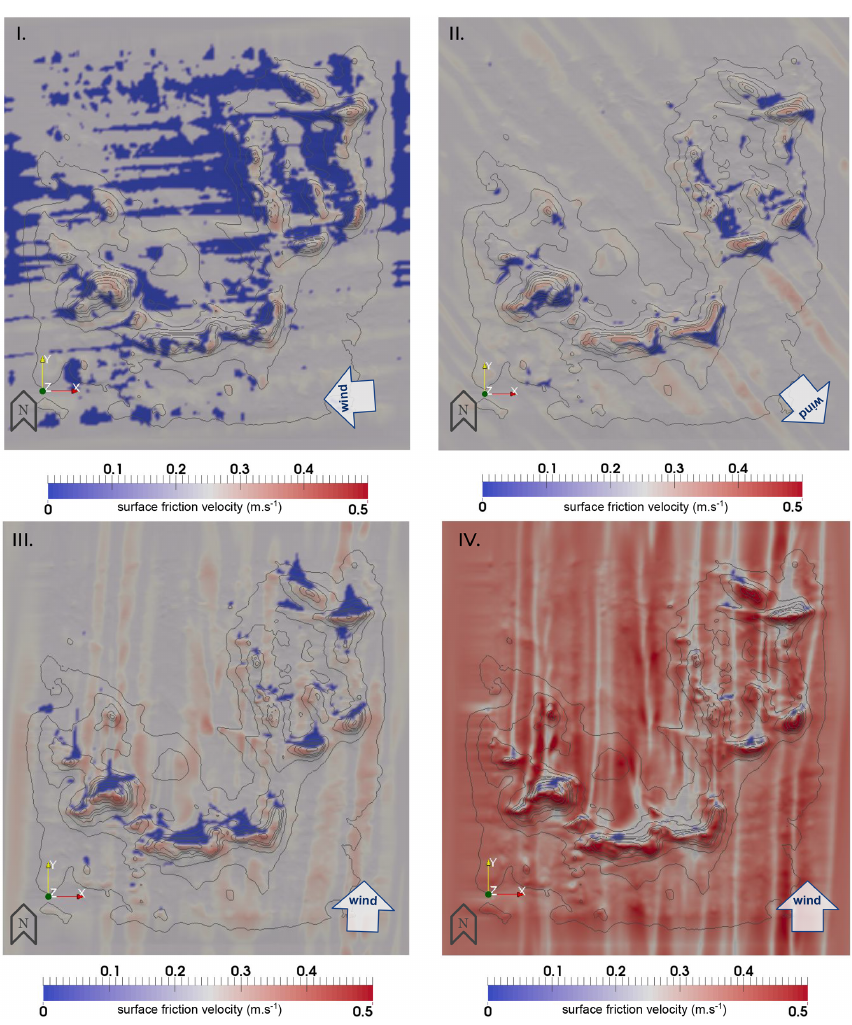
Figure 5. Friction velocity results (ms − 1 ) for the four atmospheric events (I–IV) identified in the period between the two successive laser scans. The arrows in the bottom-right corner indicate the direction of the fluid